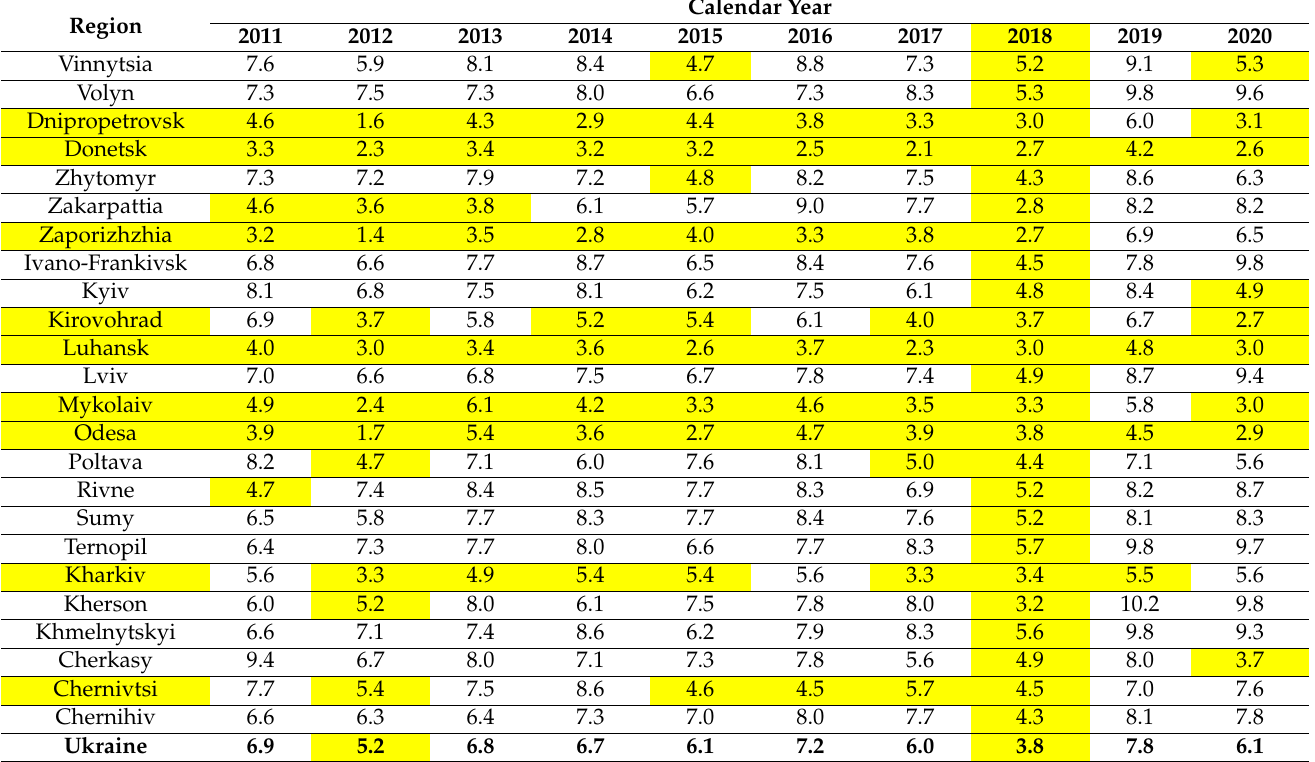
relationships between individual indicators that characterize the uneven distribution of raw materials for bioenergy. First of all, we analyzed the trends in the yield of corn for grain in some regions of Ukraine over the past 10 years (Table 1). Table 1. Yield of corn for grain in some regions of Ukraine,